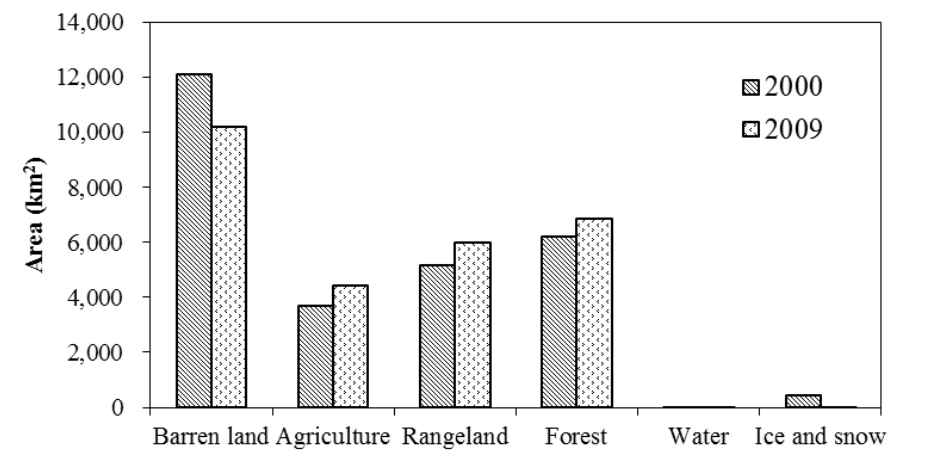
Figure 4. Changes in LULC classes from 2000 to